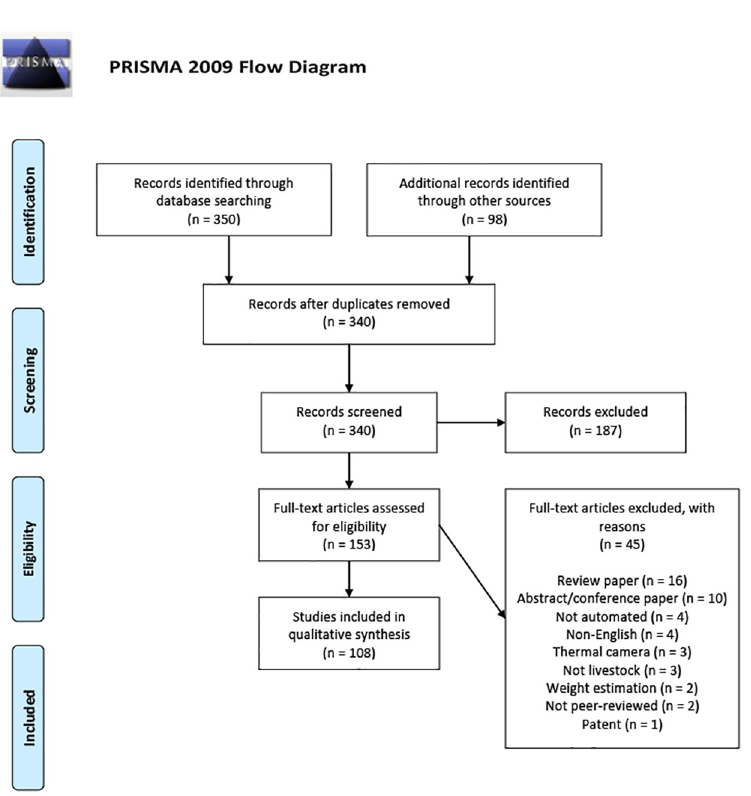
Fig 2. PRISMA flow diagram. From : Moher D, Liberati A, Tetzlaff J, Altman DG, The PRISMA Group (2009). P referred R eporting I tems for S ystematic Reviews and M eta- A nalyses: The PRISMA Statement, PLoS Med 6(7): e1000097. doi:10.1371/journal.pmed1000097. For more information, visit www.prisma-statement.org.